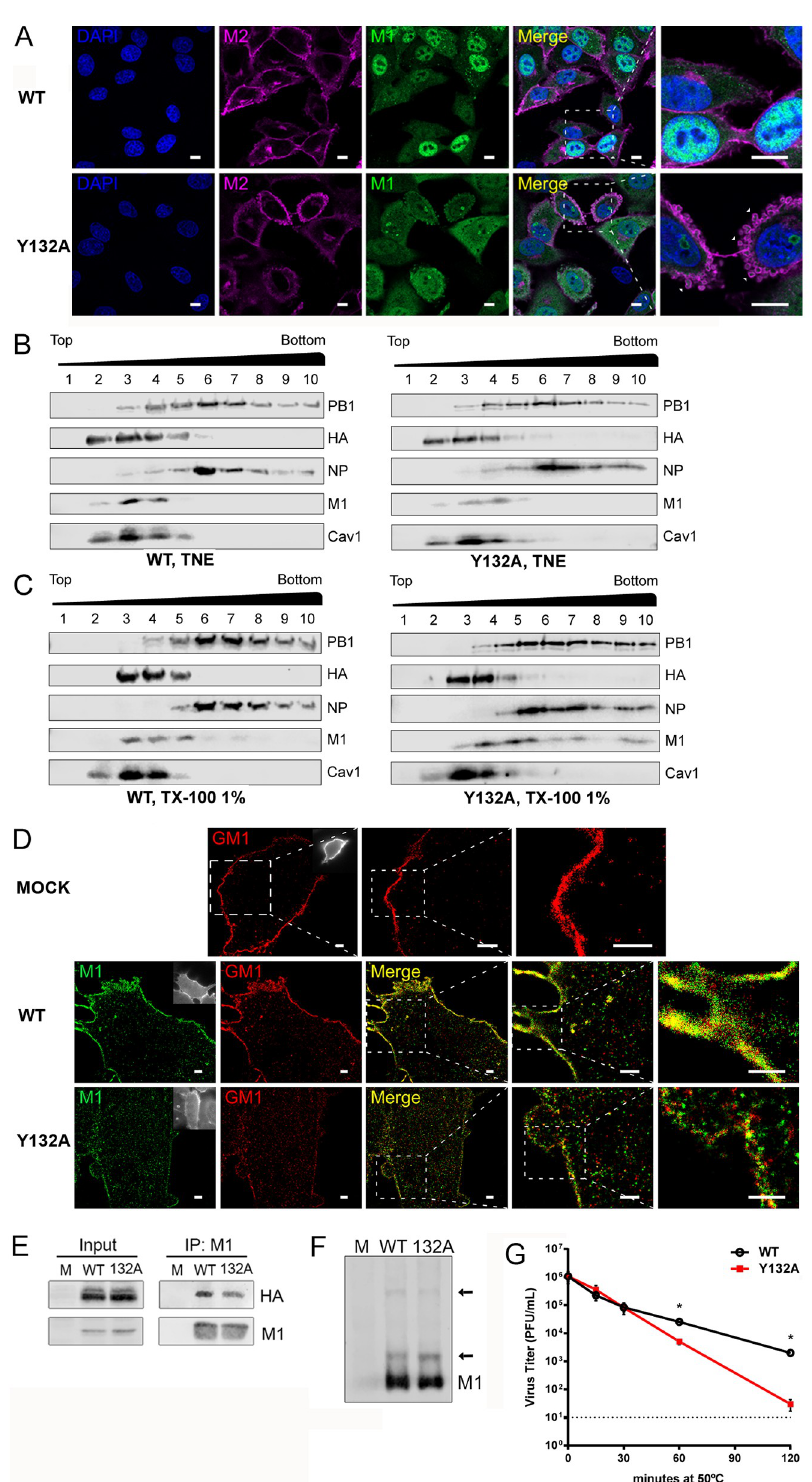
Fig 4. Phosphorylation of M1 Y132 is required for lipid raft localization and increases structural stability of virus particles. A549 cells were infected with 5 MOI WSN WT or M1 Y132A for 9 h (A-E) . A) Cells were fixed and analyzed for M1 (green) co-localization with M2 (purple) by indirect immunofluorescence. Nuclei were stained with DAPI (blue). Pictures were taken with LSM800 confocal microscope and analyzed with Fiji/ImageJ version 1.51n. Scale